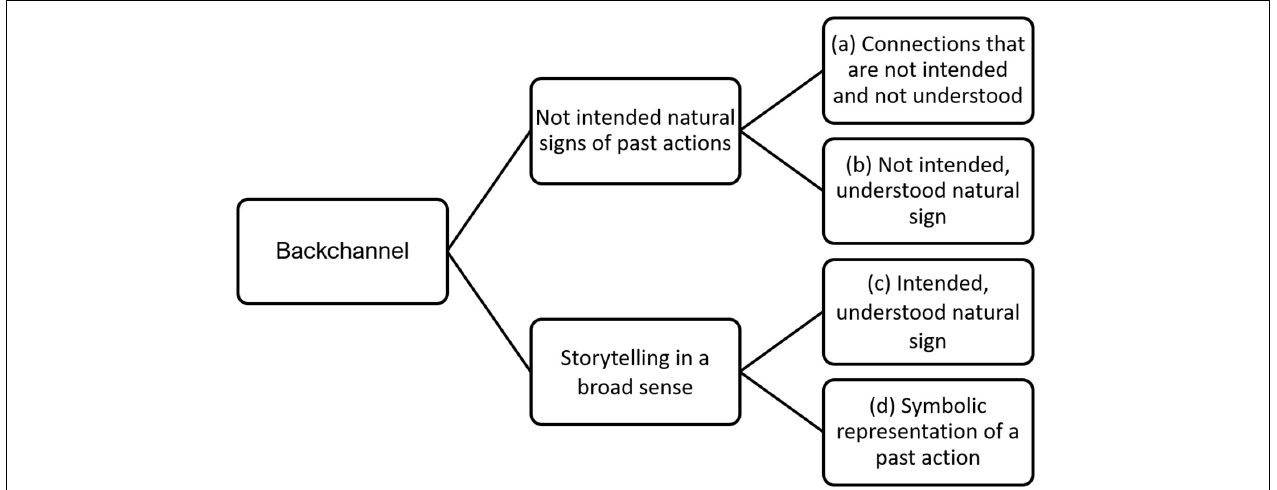
FIGURE 4 | Media of the backchannel: The four stages toward language use.